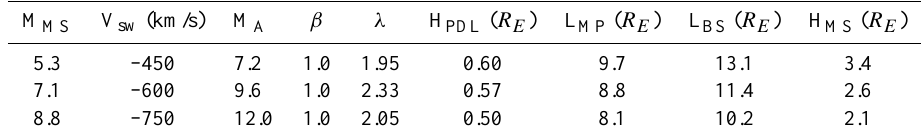
Table 3. The dependence of some important parameters along the Sun-Earth line on the solar wind M MS . M MS